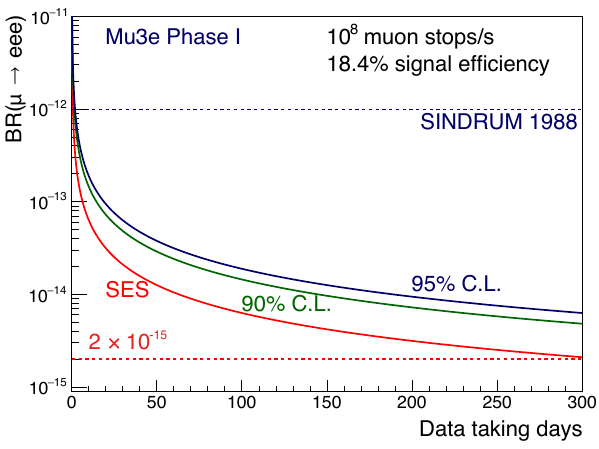
Figure 2. Single event sensitivity (SES) and corresponding 90% and 95% C.L. upper limits versus data taking days for the Phase I Mu3e detector